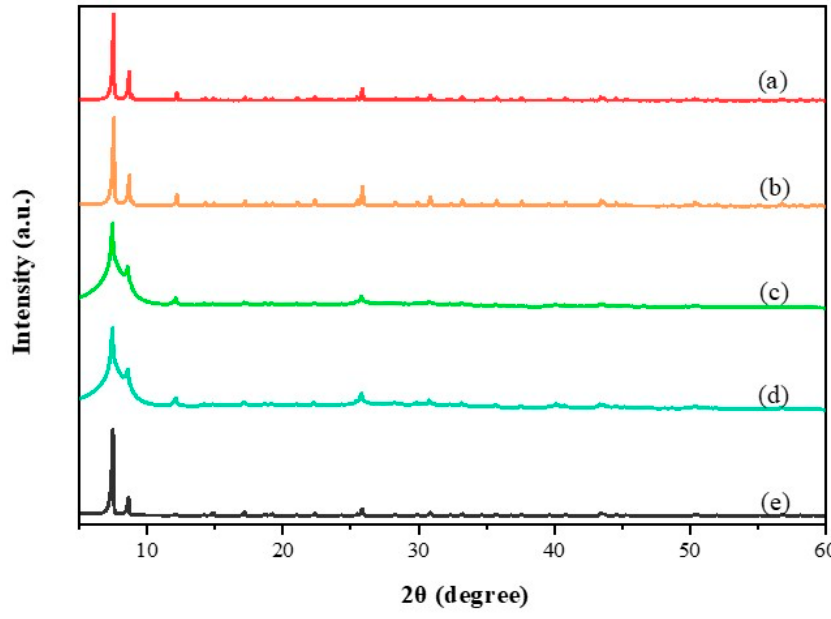
Figure 2. XRD patterns of ( a ) 0.1% Pd@U ( b ) 0.2% Pd@U ( c ) 1% Pd@U ( d ) 2% Pd@U ( e ) UIO-66.